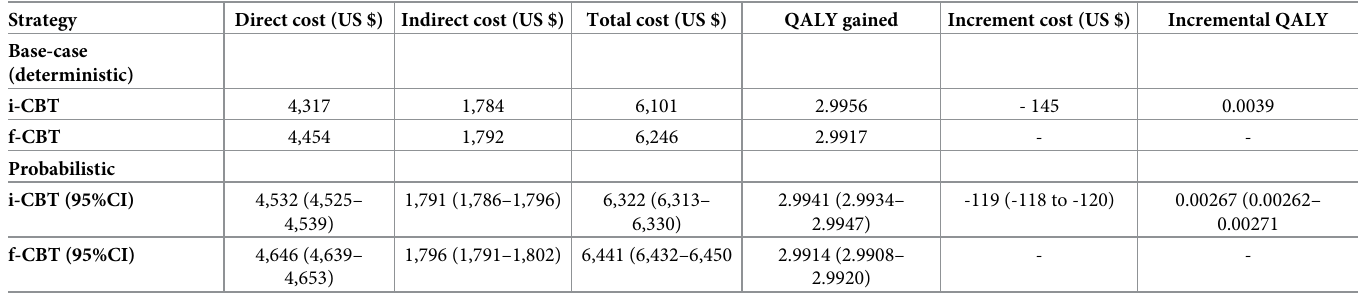
Table 2. Base-case (deterministic) and probabilistic results.